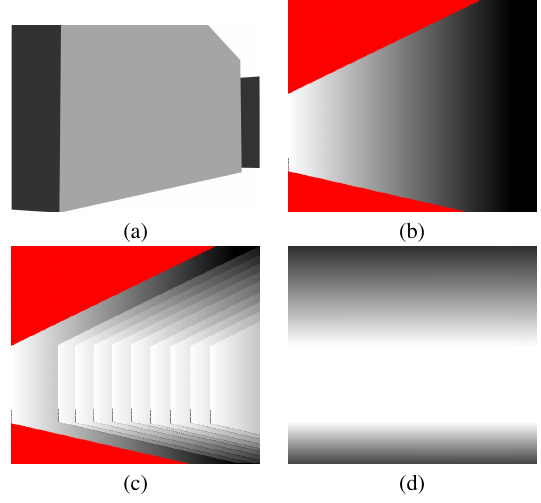
Figure 2. Geometric resolution of textures a) Oblique forward view of a facade b) Schematic view of the geometric